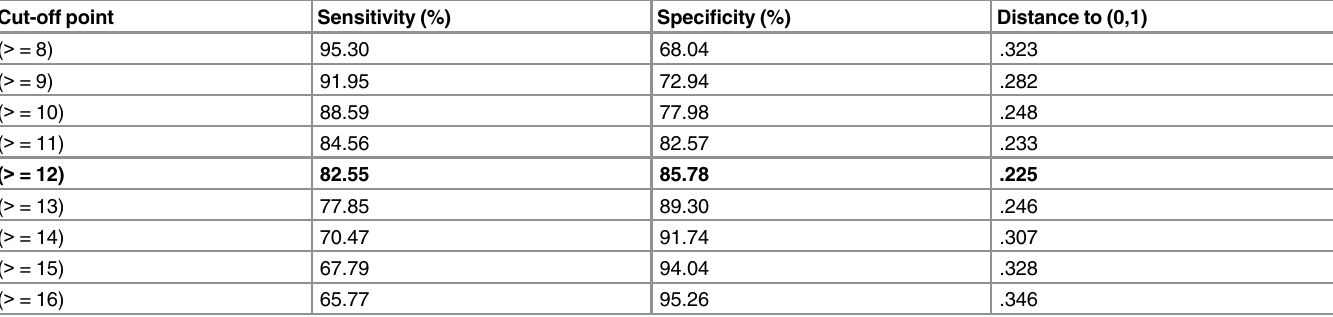
Table 1. Sensitivity, specificity, and distance to (0,1) point of each cut-off point on the HADS. Cut-off